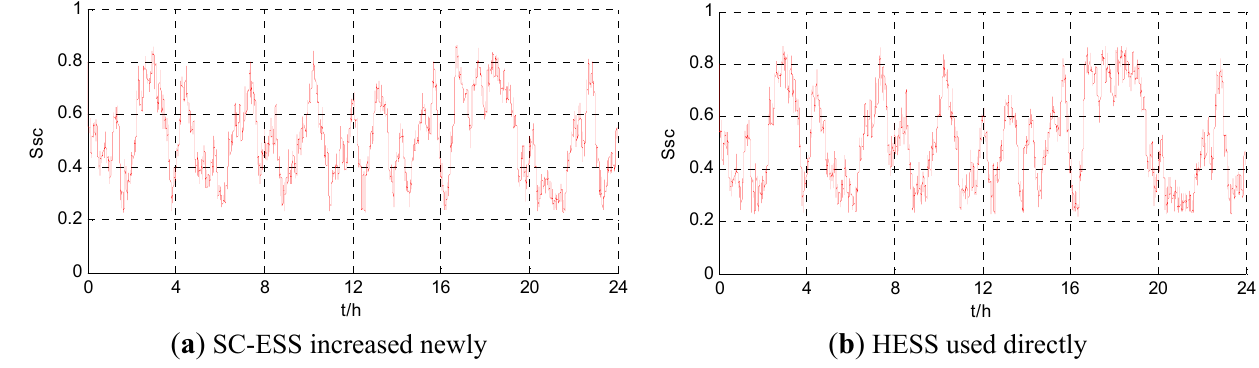
Figure 12. The SOC curves of SC-ESS in the latter two